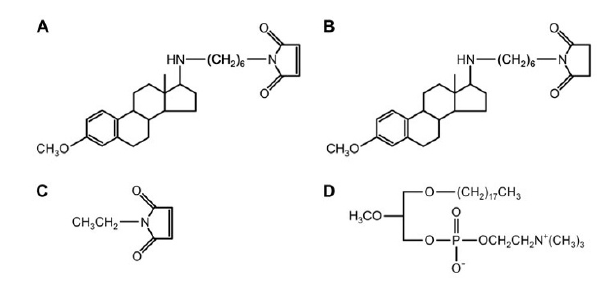
Figure 1 Chemical structures of PLC inhibitors and controls